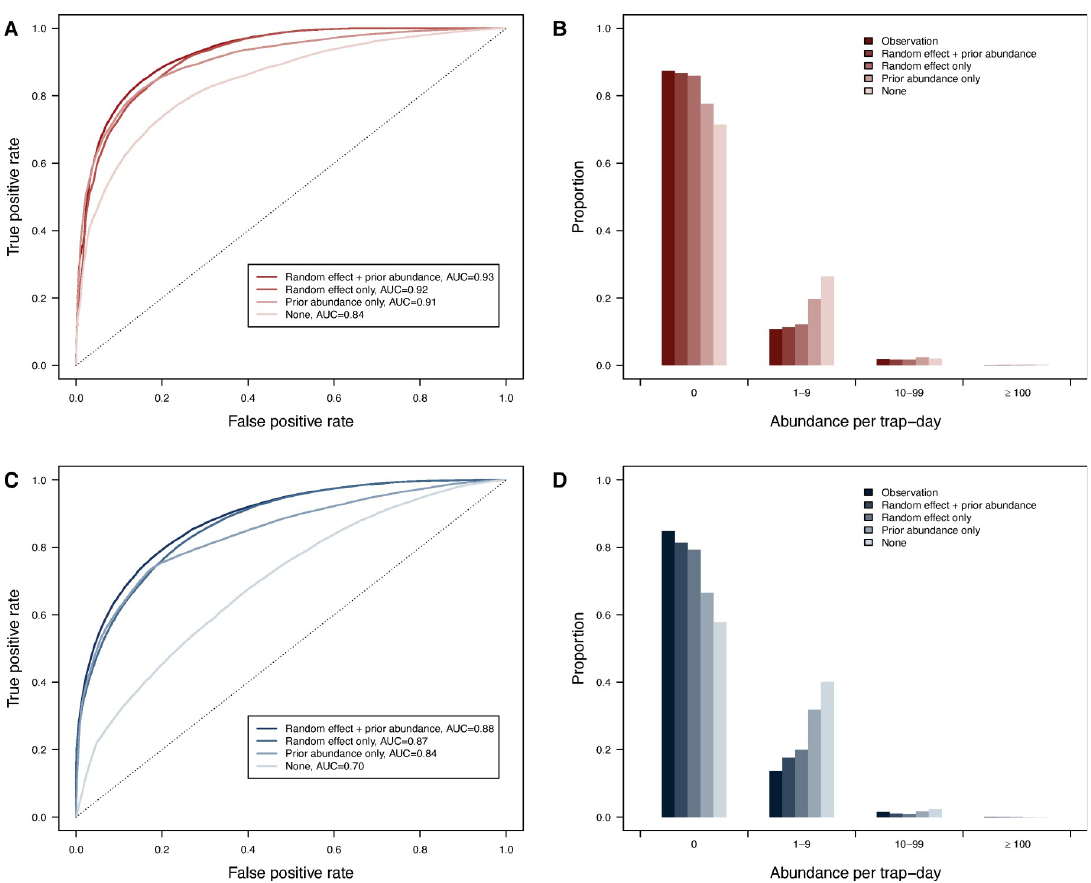
Fig 4. Model performances for different combinations of random effects and prior abundance